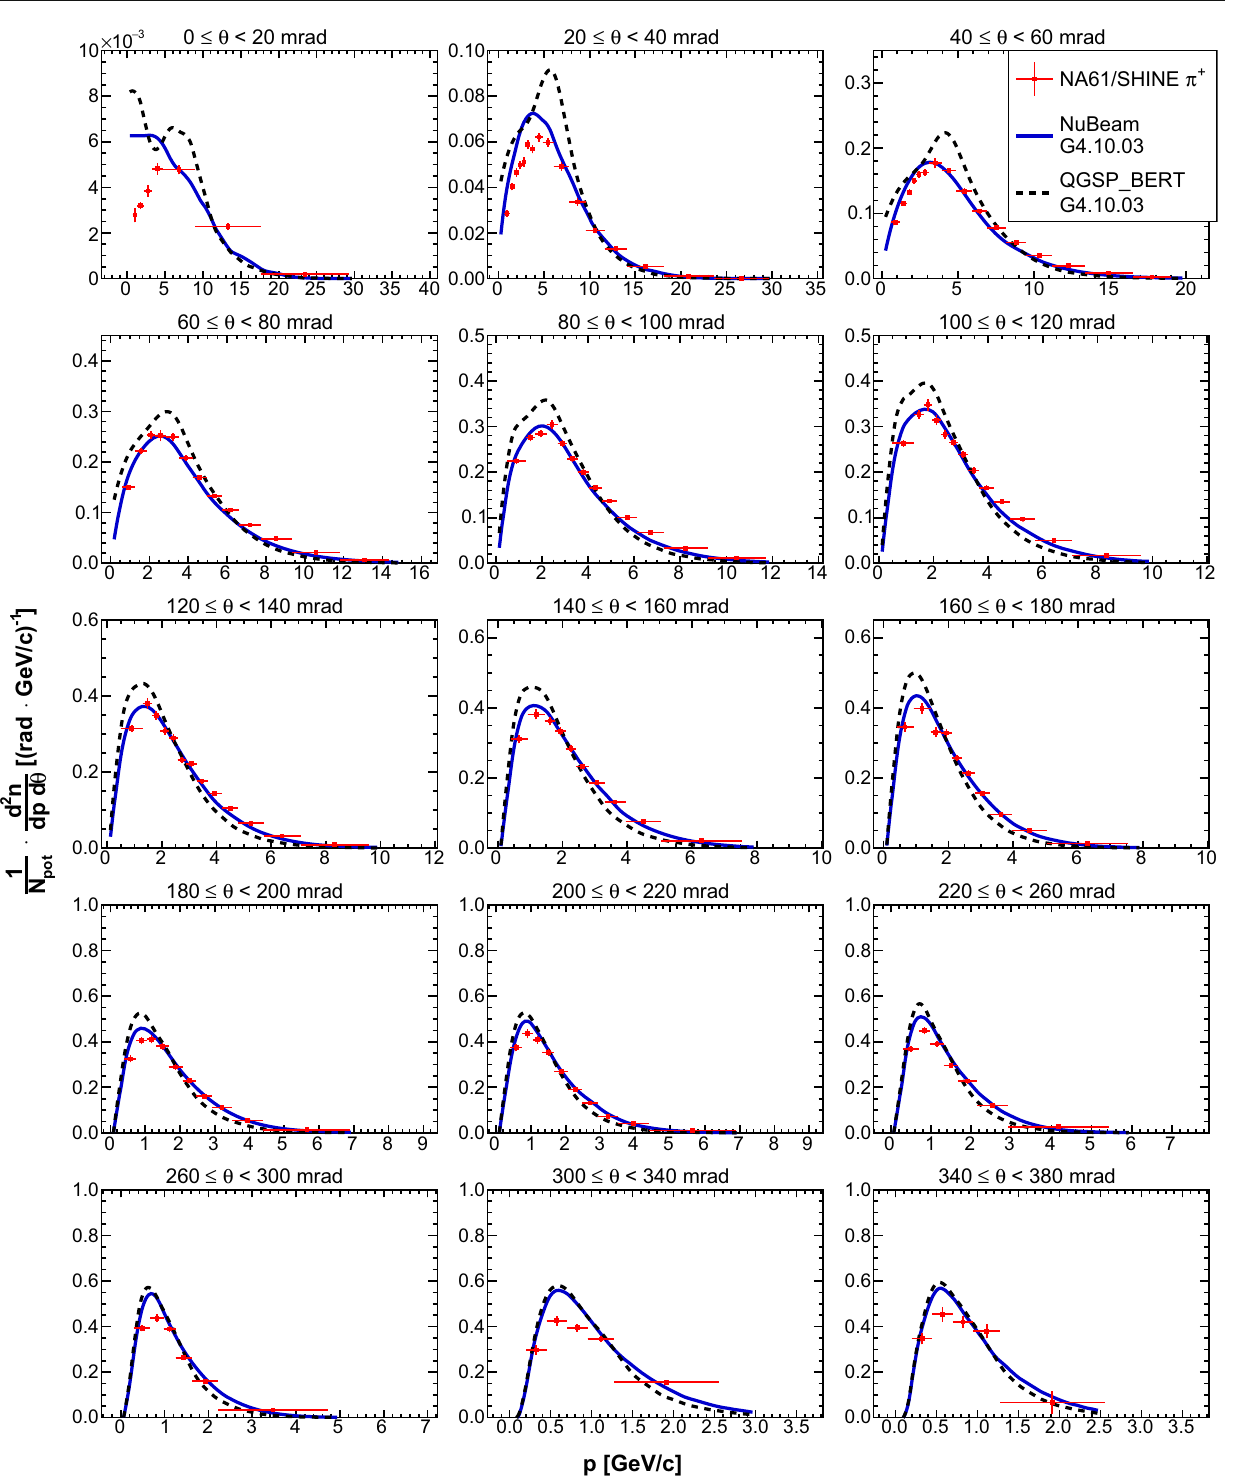
Fig. 25 Double differential yields of positively charged pions for the third upstream longitudinal bin (36 ≤ z < 54 cm). Vertical bars represent the total uncertanties. Predictions from the NuBeam